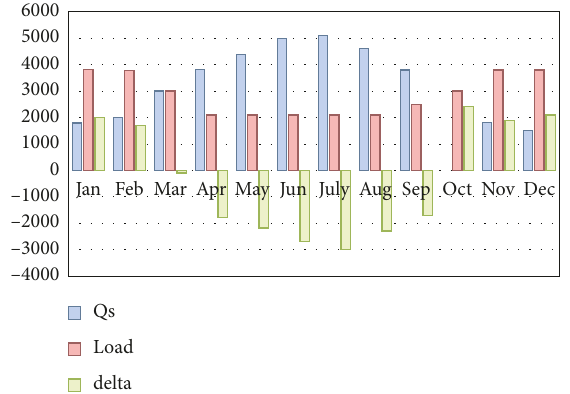
Figure 4: Electricity from the organic Rankin cycle for an index day in June.